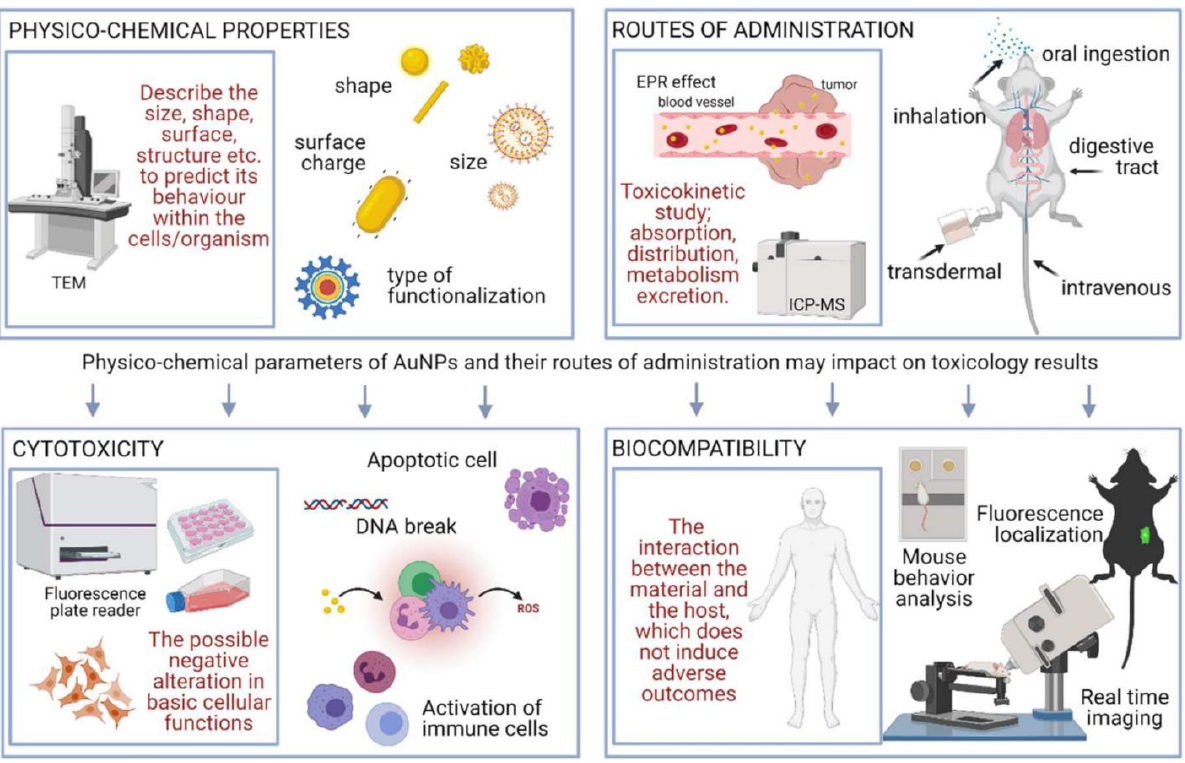
Figure 2. Schematic presentation of the various aspects regulating the biocompatibility and safety implications associated with nanoparticles, e.g., particle size or hydrodynamic diameters, nanopar- ticle shape and surface morphological characteristics, and routes through which nanoparticles are administered into the patients, considerably regulate the safety and toxicological outcomes including the adverse effects (viz. apoptotic changes, reactive oxygen species yield, abnormality in animals’ behaviors, etc.). These prospects can be assessed on cellular or organismic levels (reproduced with permission from [32]).